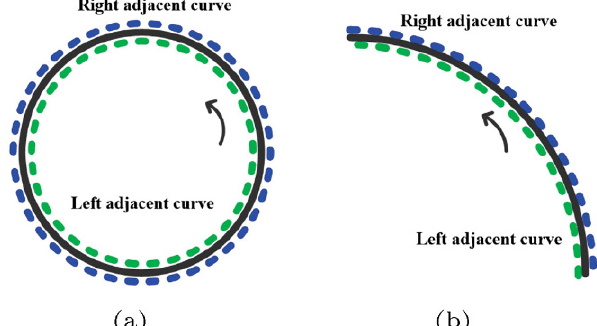
Fig. 3 Left adjacent curve (green) and right adjacent curve (blue) to (a) a closed color source curve (black) and (b) an open color source curve (black), respectively.